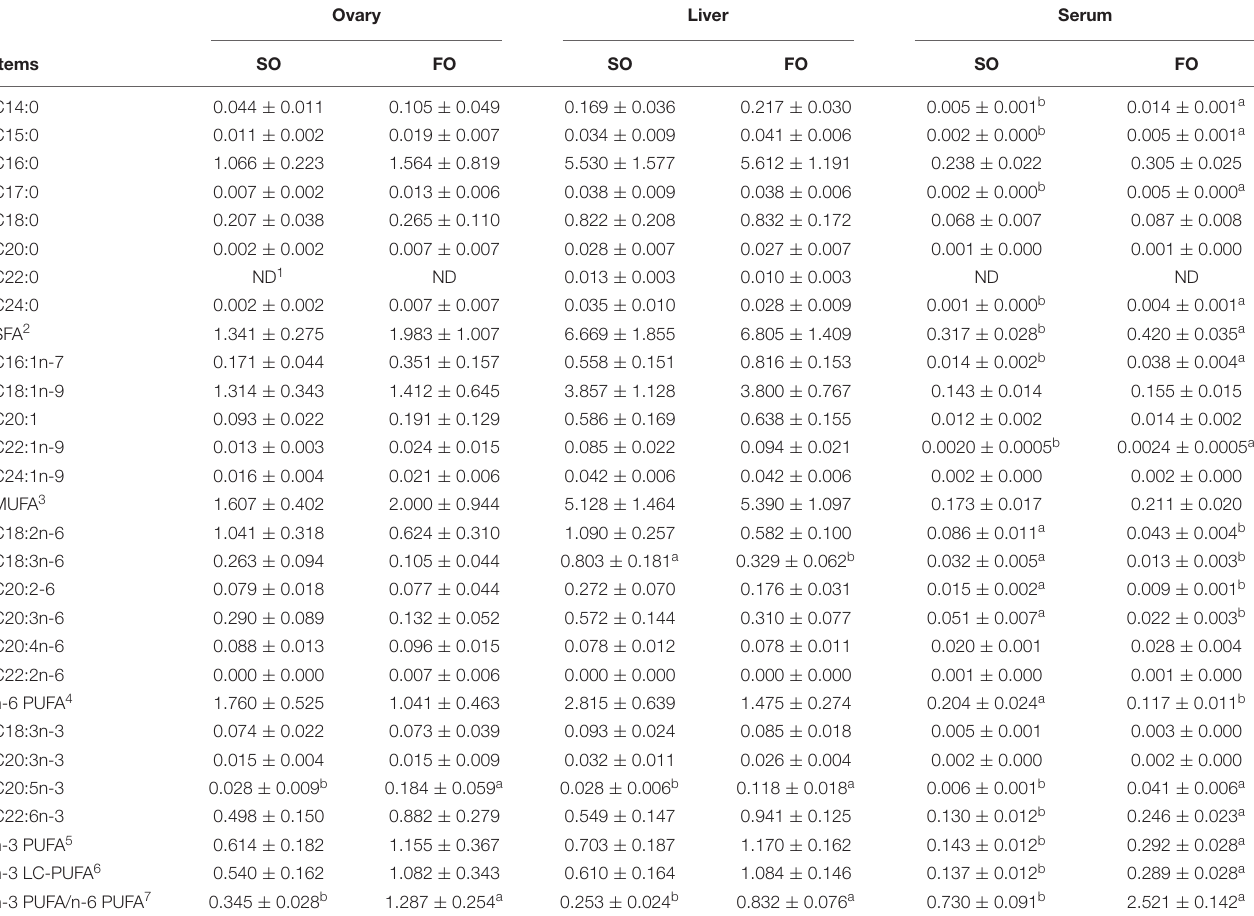
TABLE 3 | Fatty acid composition in different tissues of the female spotted scat fed with different oil sources. Ovary Liver